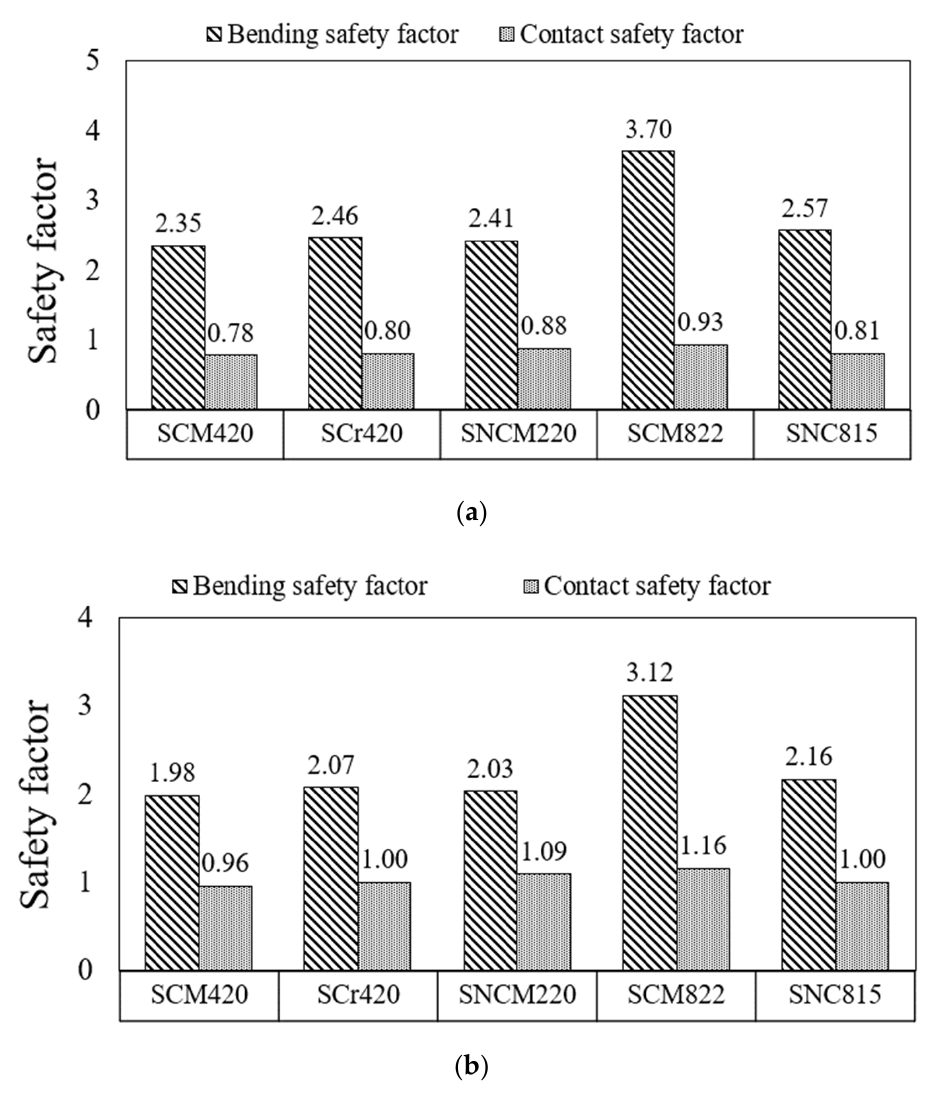
Figure 9. Results of safety factor analyses for the range shift A gears with different materials: ( a ) driving gear; ( b ) driven gear.